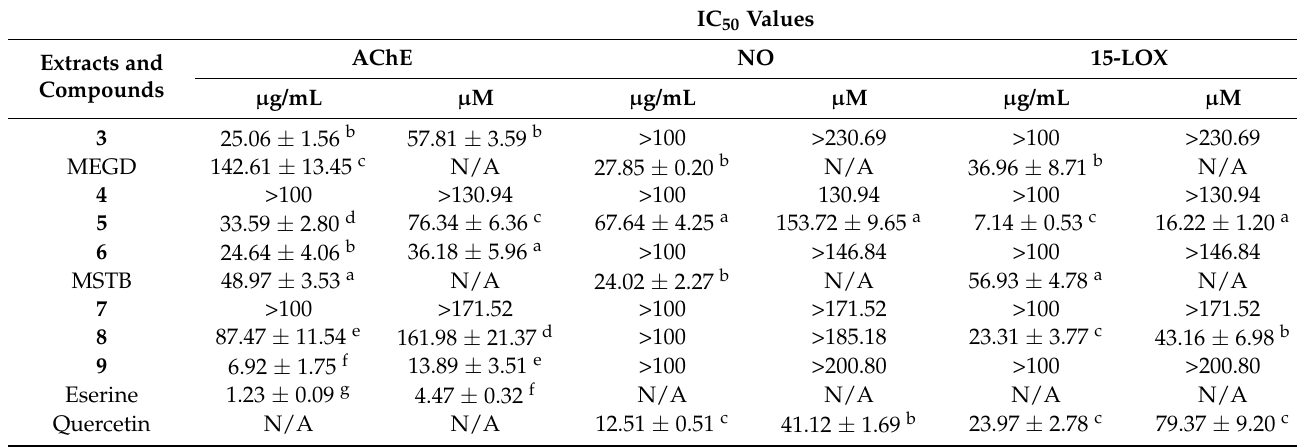
Data are presented as the means of triplicate measurements ± standard deviation; superscript letters a–g rep- resent statistical difference between data obtained, and for each column of the above table, data with same letters are statistically not different while data with different letters are significantly different at p < 0.05. IC 50 : concentration required to inhibit the biological effect by 50% compared to untreated controls. MLPC: methanol